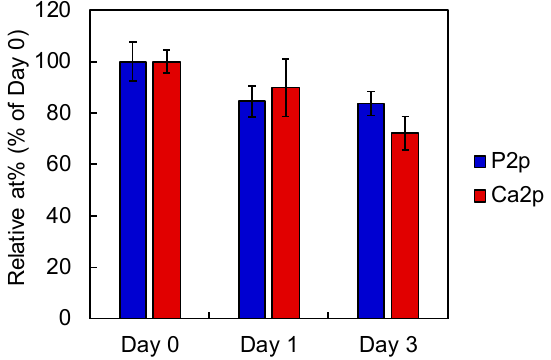
Figure 3. Phosphate and calcium release profile from phosphate and calcium co-immobilized PEEK after immersing in saline at 37 °C ( n = 4). Data are the mean ± standard derivation.